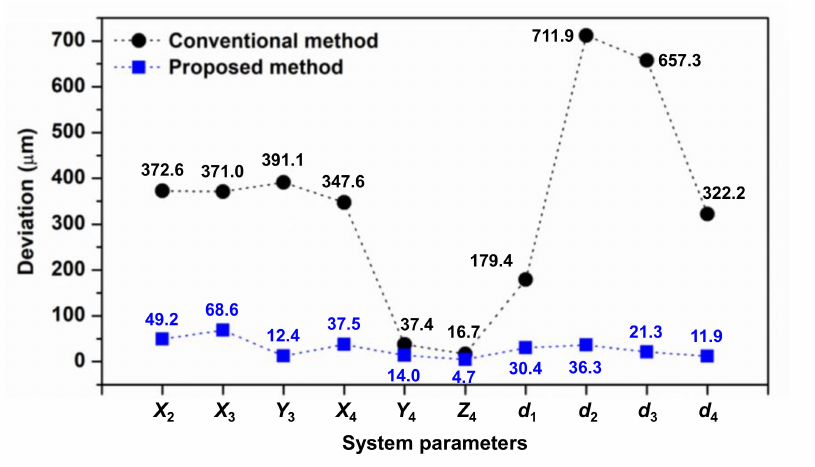
Figure 10. Deviation of the estimated system parameters in three